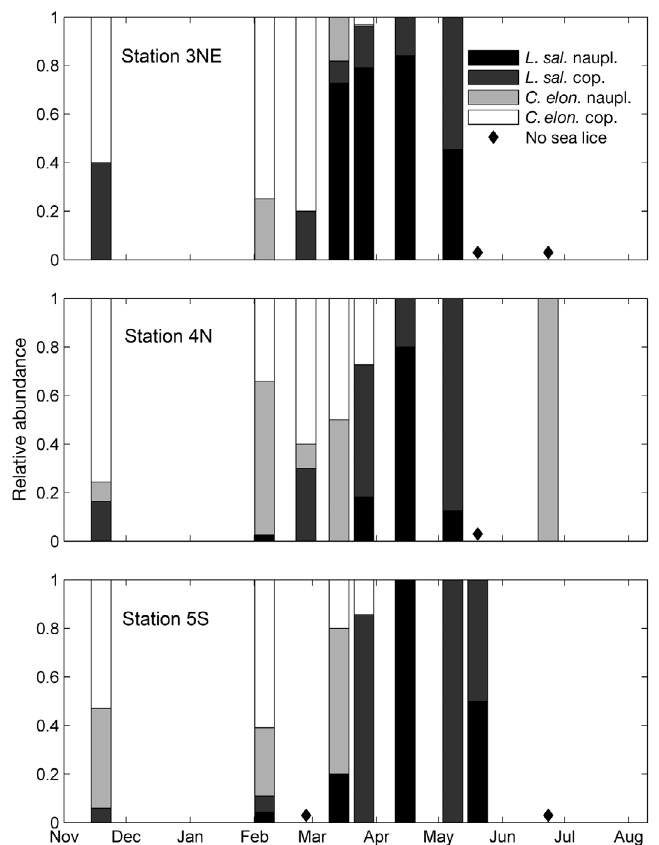
Fig. 6. Lepeophtheirus salmonis and Caligus elongatus . Rel- ative abundance of nauplii and copepodids in the top meter of the water column from November 2013 to June 2014 at the 3 time series